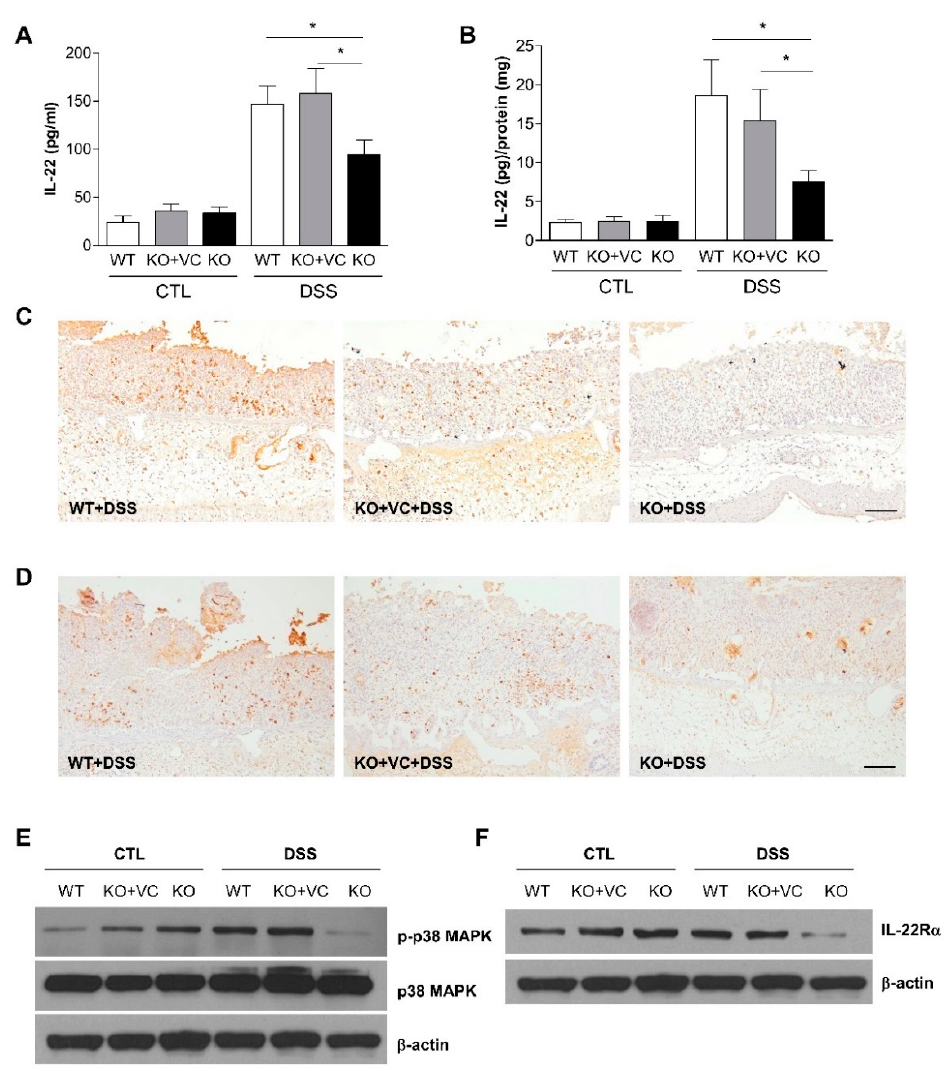
Figure 3. Vitamin C insufficiency and DSS treatment decrease IL-22 production and IL-22R α expres- sion. Mice were treated with DSS for 7 days, and the level of IL-22 in ( A ) plasma ( n = 7–11) and ( B ) colon homogenates ( n = 12–14) was measured with ELISA. The final tissue IL-22 concentration was normalized to proteins in colonic homogenates. * p < 0.05. ( C ) IL-22-producing cells and ( D ) the population of infiltrated NKp46(+) cells in the colon were stained using immunohistochemistry. Scale bar, 100 µ m. ( E ) The phosphorylation of p38 MAPK in colon lysates was examined with immunoblotting. The results are representative of three independent experiments. ( F ) The expression of IL-22R α was examined by immunoblotting. β -actin was used as an internal control. The results are representative of three independent experiments. Statistical analysis was performed using the Tukey multiple comparisons test after one-way ANOVA.